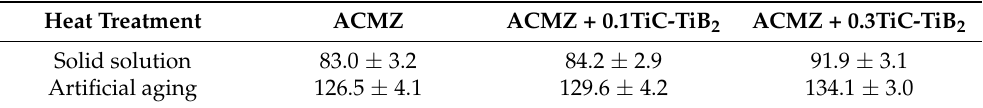
Table 2. Average value and standard deviation of surface hardness (HV) of different alloys under different heat treatment conditions.